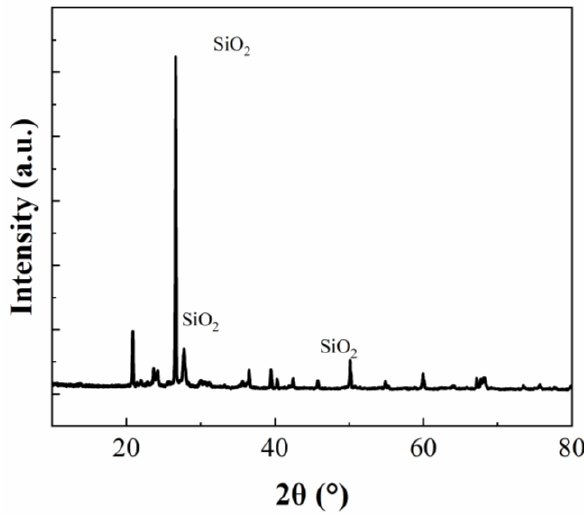
Figure 21. XRD analysis of MGB sintered brick.